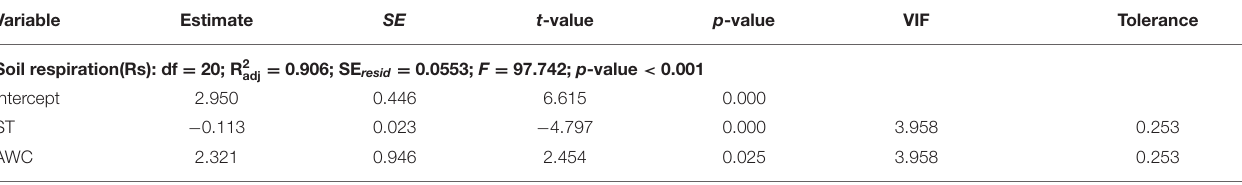
TABLE 2 | Summary of the results of multiple linear stepwise regression analysis of the effects of environmental factors on soil respiration (Rs). Variable